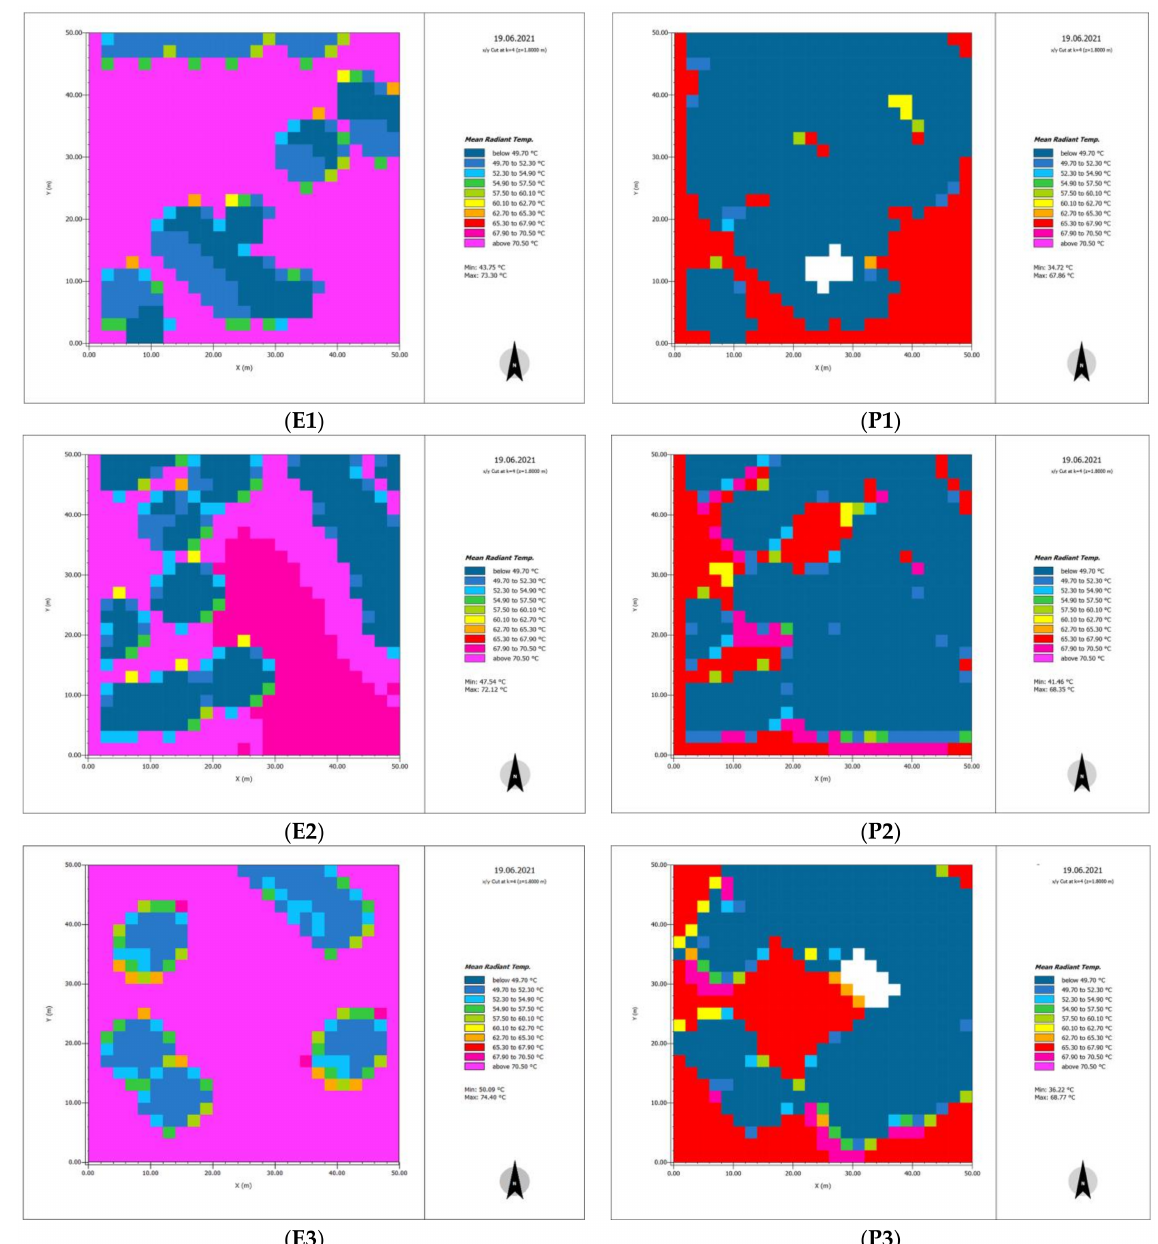
Figure 8. Mean radiant temperature results (The more blue areas there are, the lower the temperature; the white represents the